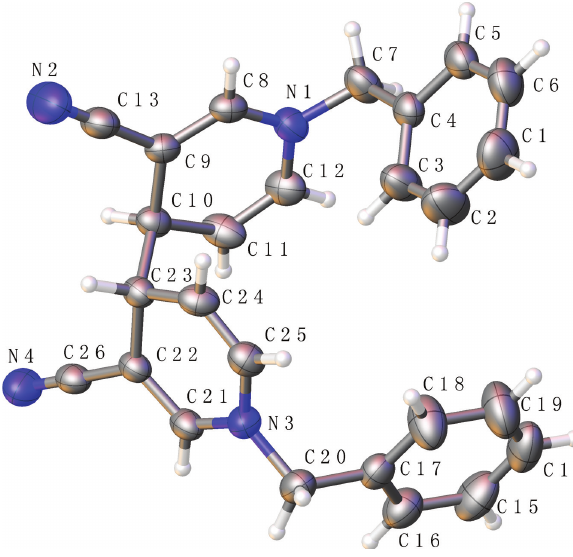
Table 1: Data collection and